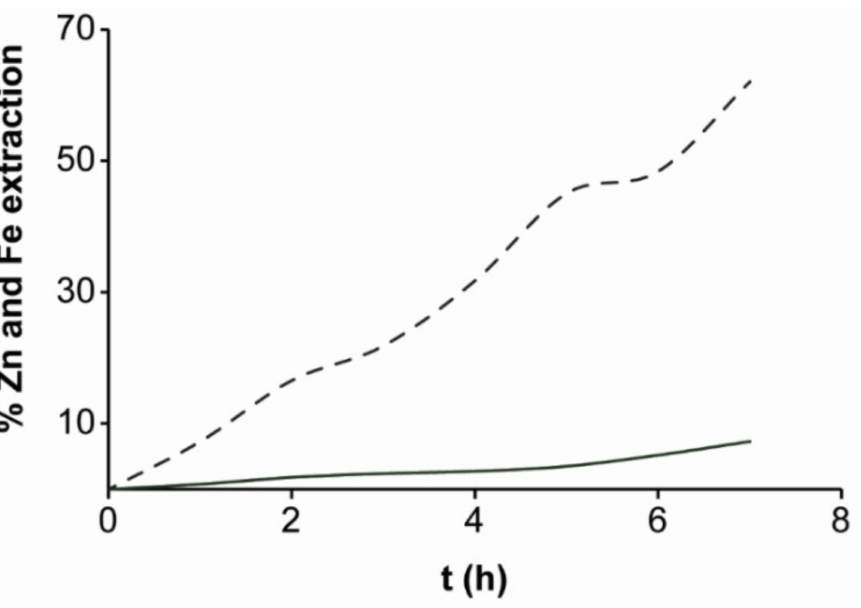
Figure 18. Percentage of extracted zinc and iron at 25 ◦ C as related to the initial sphalerite sample (Zn, 5 g; Fe, 0.7g) doped with graphite. Full lines represent Zn; dashed lines,